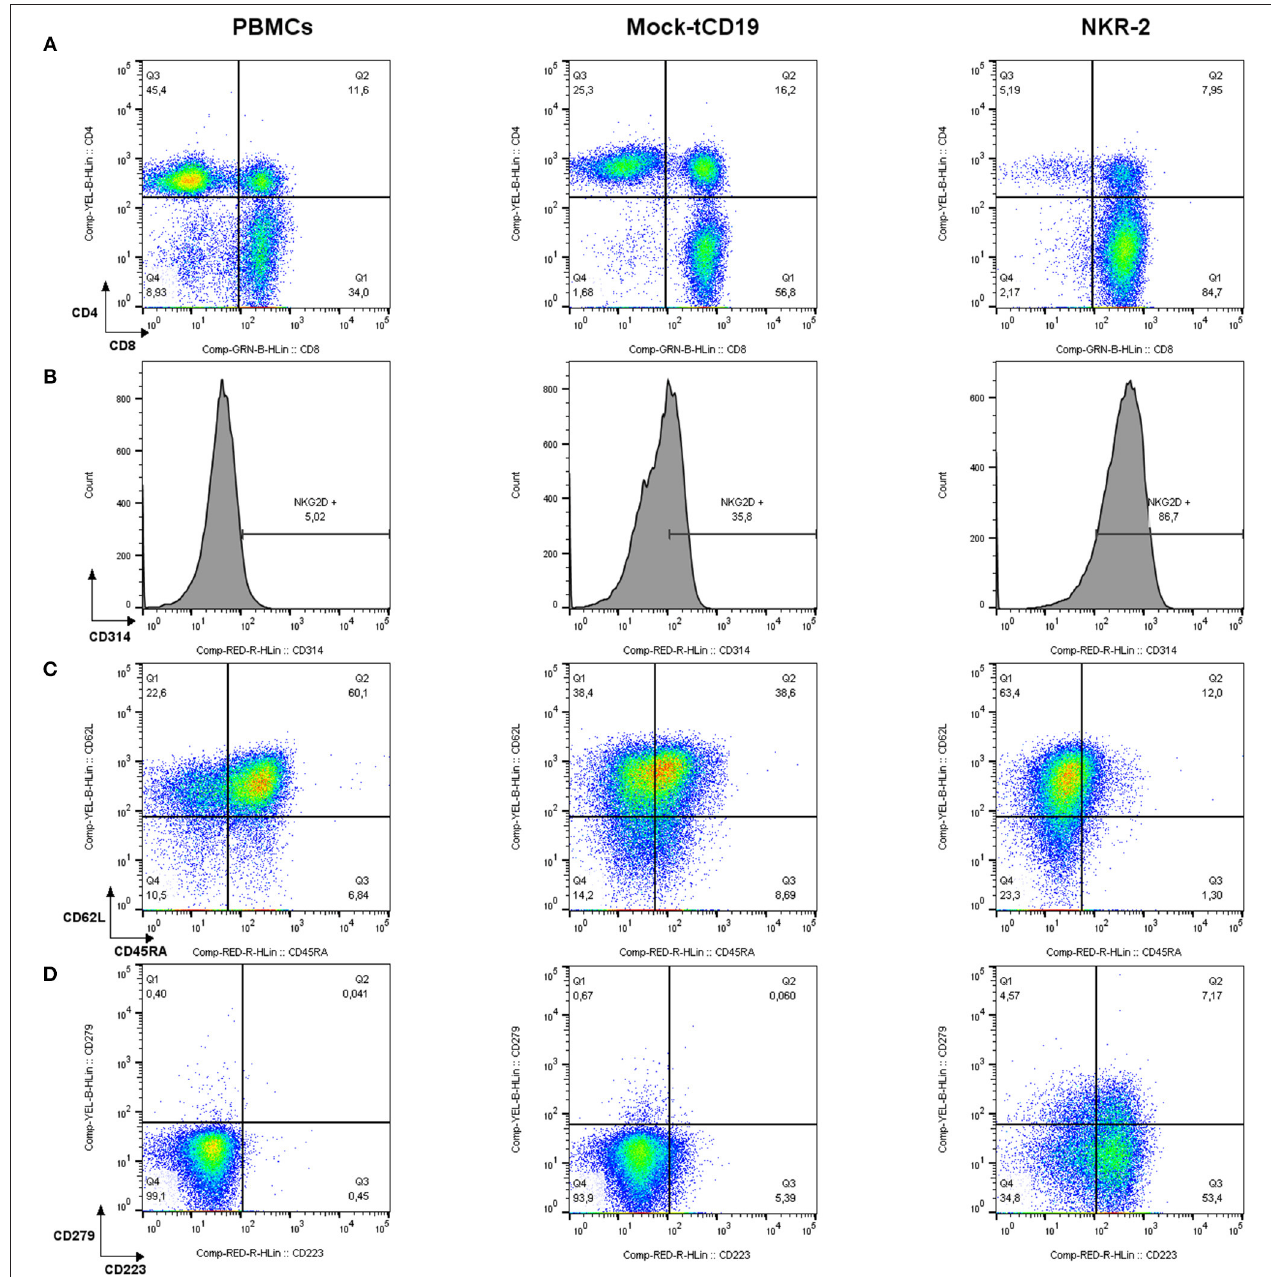
FIGURE 1 | Flow cytometric characterization of PBMCs, tCD19, and NKG2D-CAR T cells in a representative NKR-2T cells process. Mononuclear cells purified from blood using density gradient method were analyzed before (PBMCs) and after (tCD19 and NKR-2T cells) the NKR-2T cells process. After acquisition, cells were gated on SSC/FSC for Lymphocytes. Lymphocytes were then gated on CD3. All CD3 positive cells were then displayed as followed: (A) CD4/CD8 distribution. (B) Surface expression of NKG2D (CD314). (C) Memory phenotype. CD62L and CD45RA for the distinction of Naïve (CD62L + CD45RA + ), central memory (CD62L + CD45RA–), effector memory (CD62L– CD45RA–), and terminal differentiated T cells expressing CD45RA (CD62L– CD45RA + ) and (D) Exhaustion phenotype as stained for CD223 (Lag-3) and CD279 (PD-1). One representative donor out of 3 is